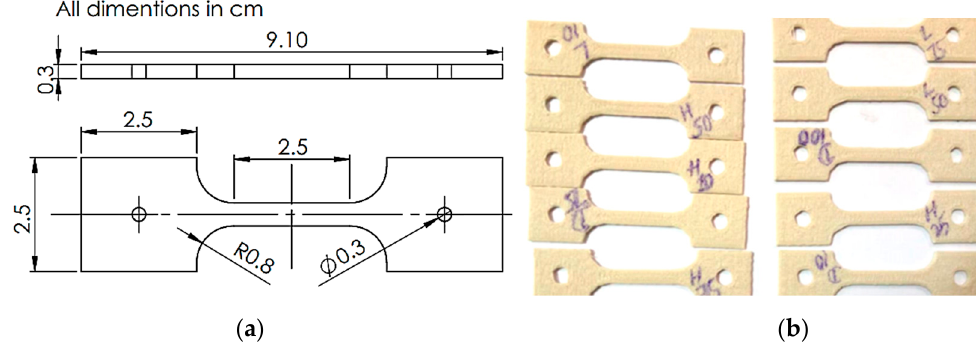
Figure 4. ( a ) Creep test specimen as per ASTM D2990 standards. ( b ) Printed creep specimens.